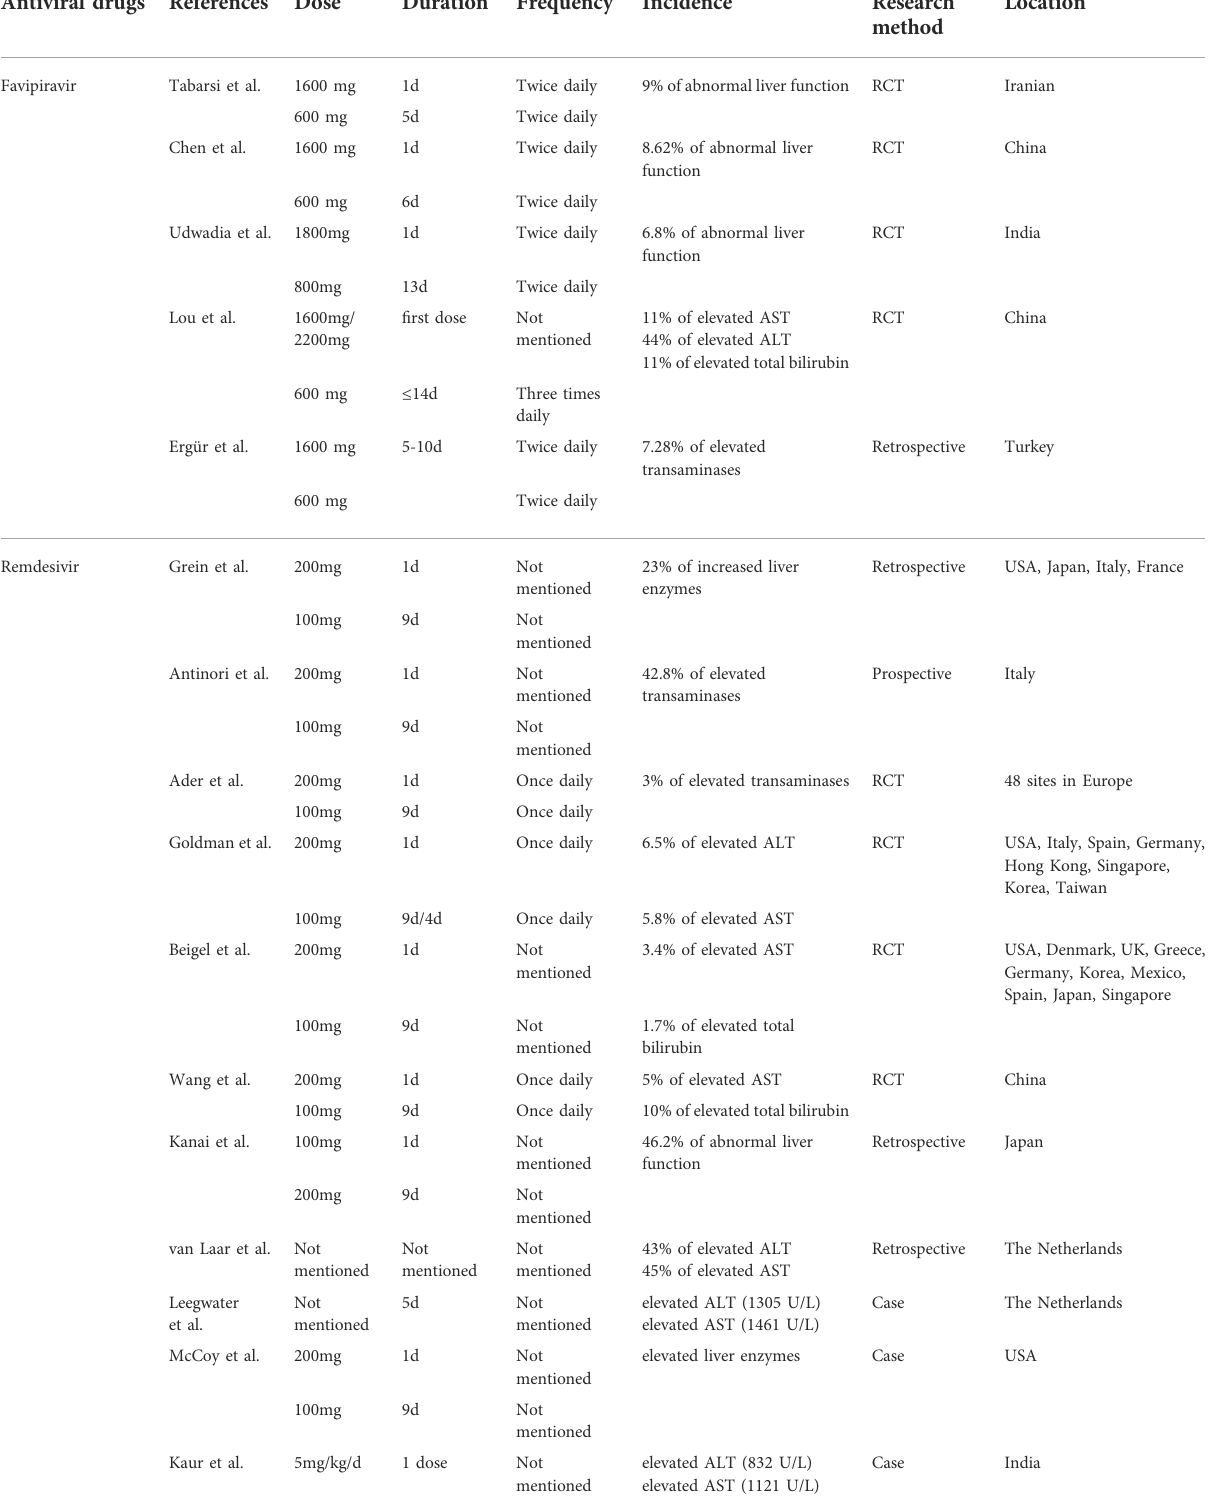
TABLE 1 Incidence of abnormal liver function and medication regimen during the antiviral treatment of COVID-19 patients. Antiviral drugs